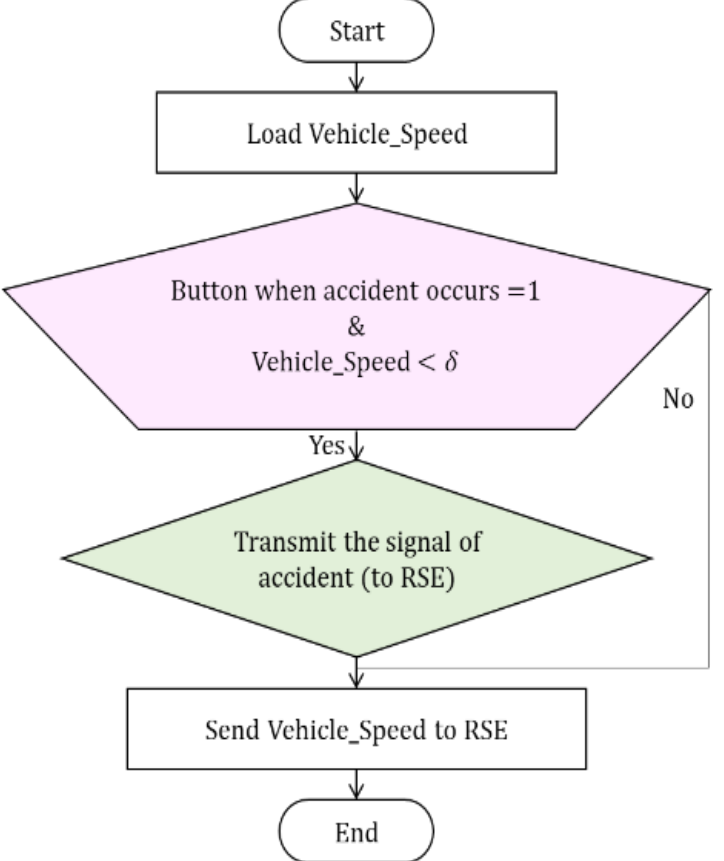
Figure 3. The traffic accident prevention communication algorithm.